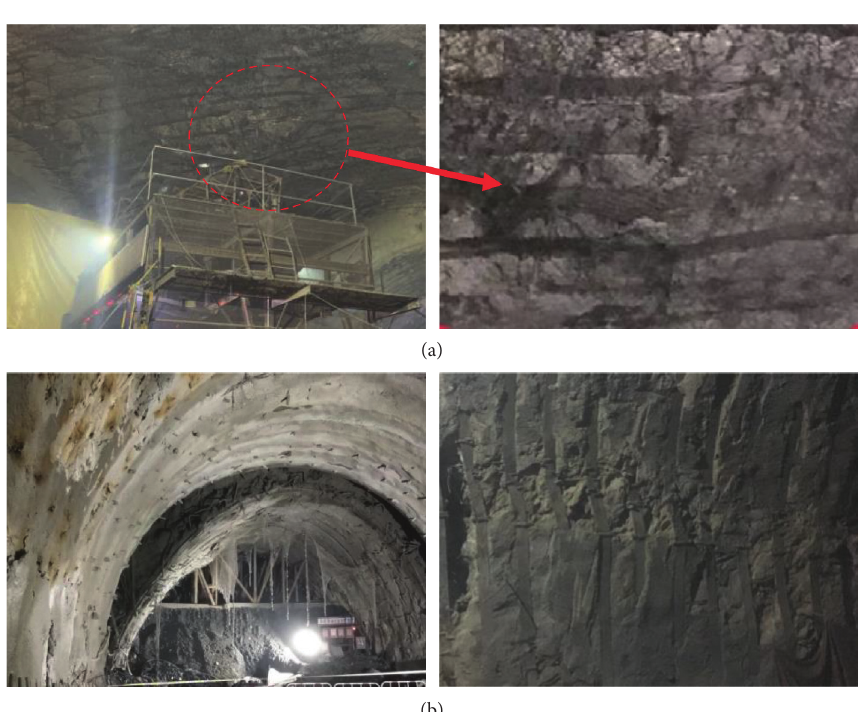
Figure 5: Photos of deformation and damage. (a) Deformation of the vault at the intersection. (b) Large deformation of inclined shaft 3#.